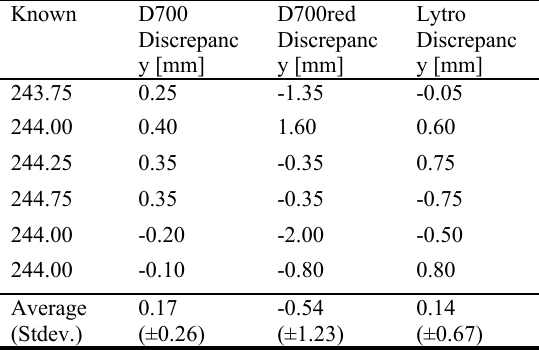
Figure 6. The sampling areas (cropped out holes) are distributed over the flat areas on the floor and the rougher areas along the mannequin the suitcase and the desk chair. Furthermore, the top left corner in red shows a large hole in the laser scan which could be documented using photogrammetry. Table 1. Discrepancies of the measurement cross measured in 3D model to real value.